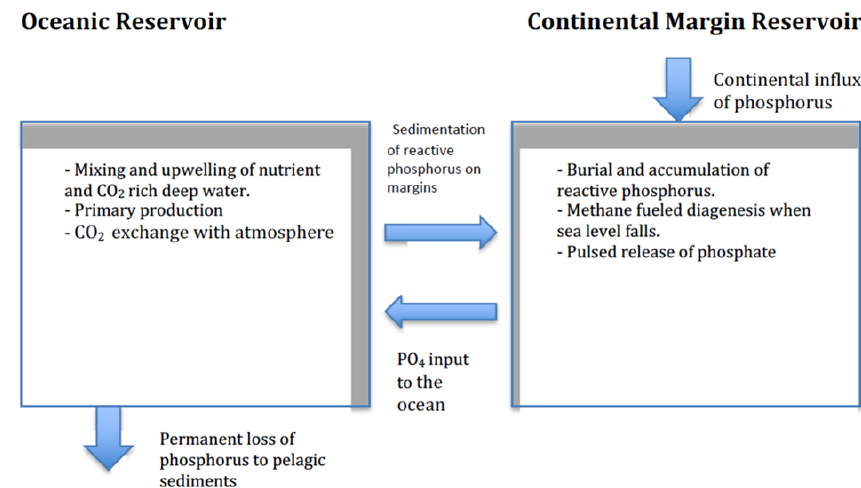
Figure 1. A simple two-reservoir representation of the oceanic phosphorus